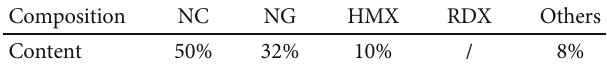
Table 1: Composition of the CMDB